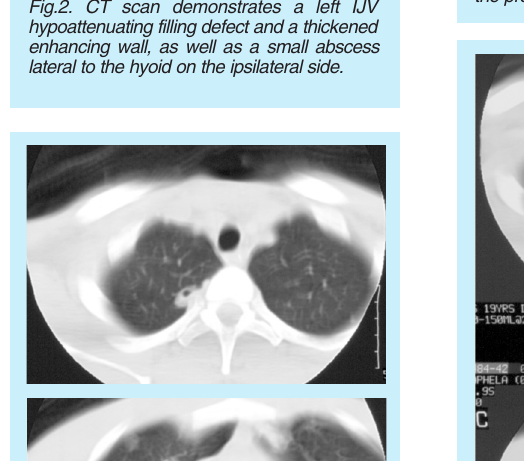
Fig.4. Repeat CT scan of the neck demon- strates ongoing left IJV thrombosis, without the presence of parietal contrast fixation.